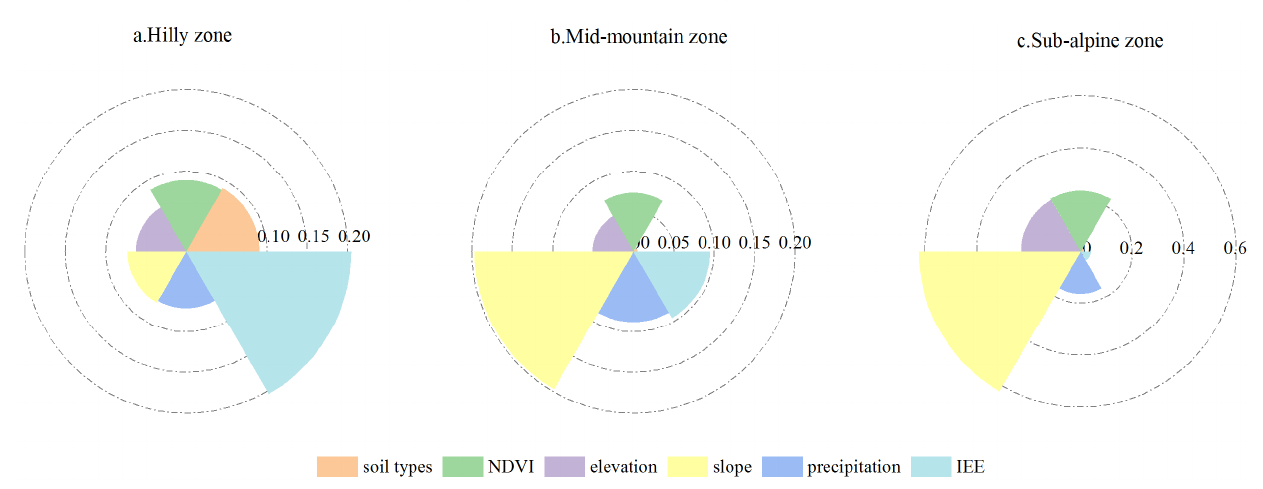
Figure 10. Q values of factors influencing the SCSs in the different elevation zones in 2020.